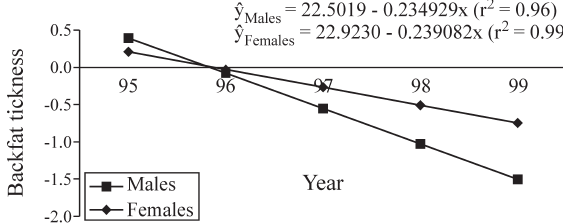
Figure 3 - Direct genetic trends for backfat tickness (mm) from 1995 to 1999.